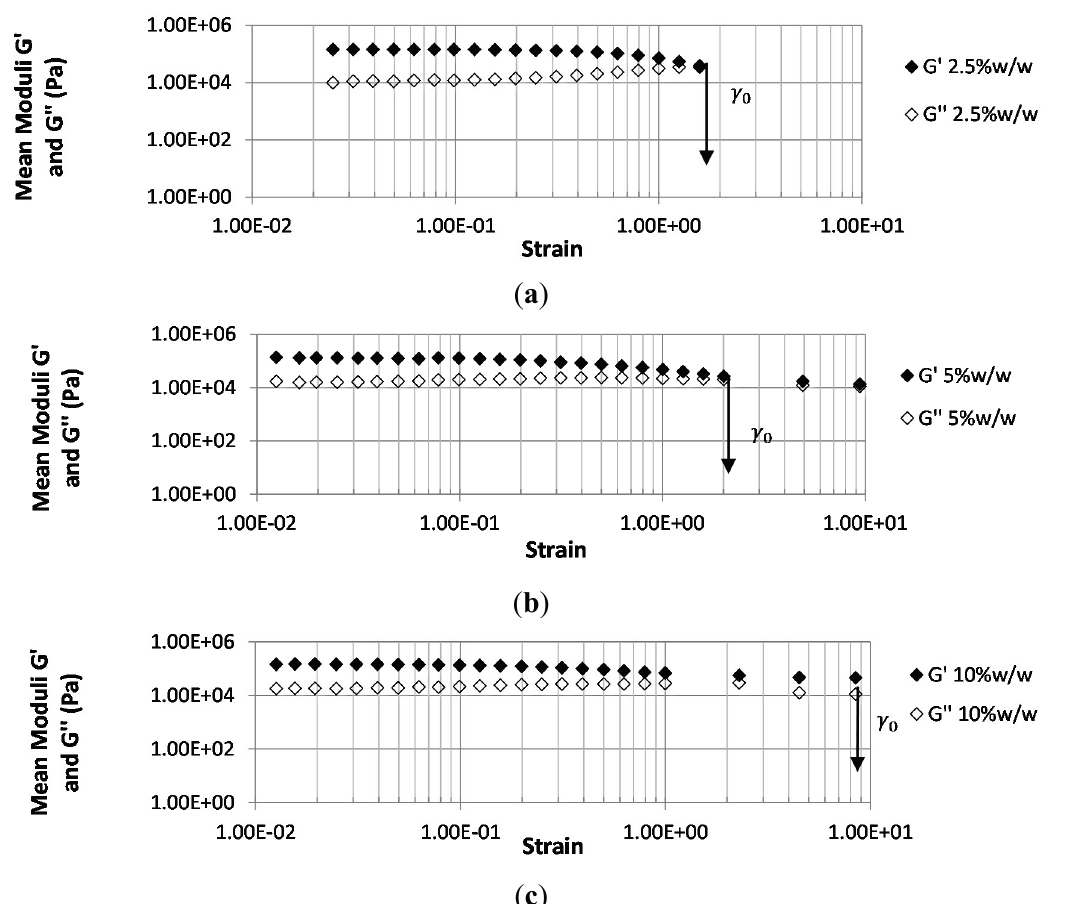
Figure 5. Log–log plot of shear moduli (elastic (G’) and viscous (G’’)) vs. strain for PEO hydrogels containing various PETRA concentrations ( a ) 2.5% w / w , ( b ) 5% w / w , and ( c ) 10% w / w . Frequency = 1 Hz and temperature = 25